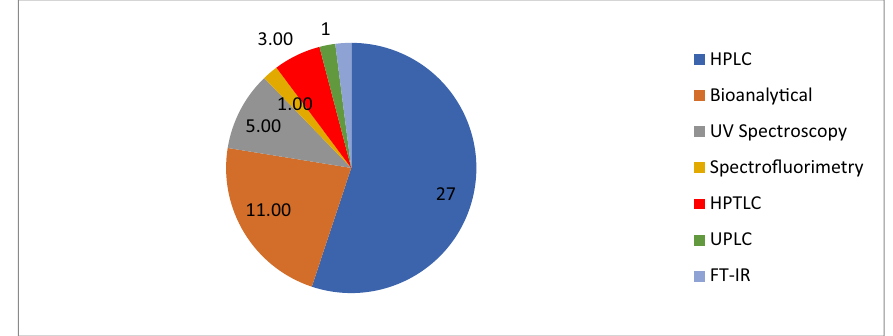
Figure 2: Analytical methods for the estimation of